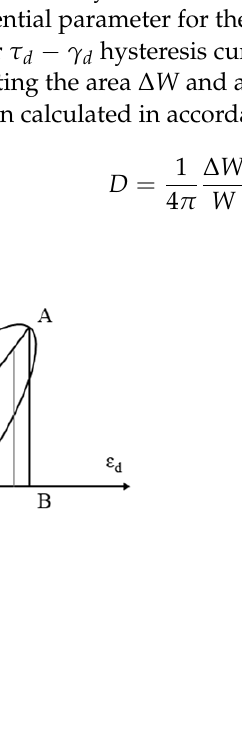
Figure 10. Calculation method of the damping